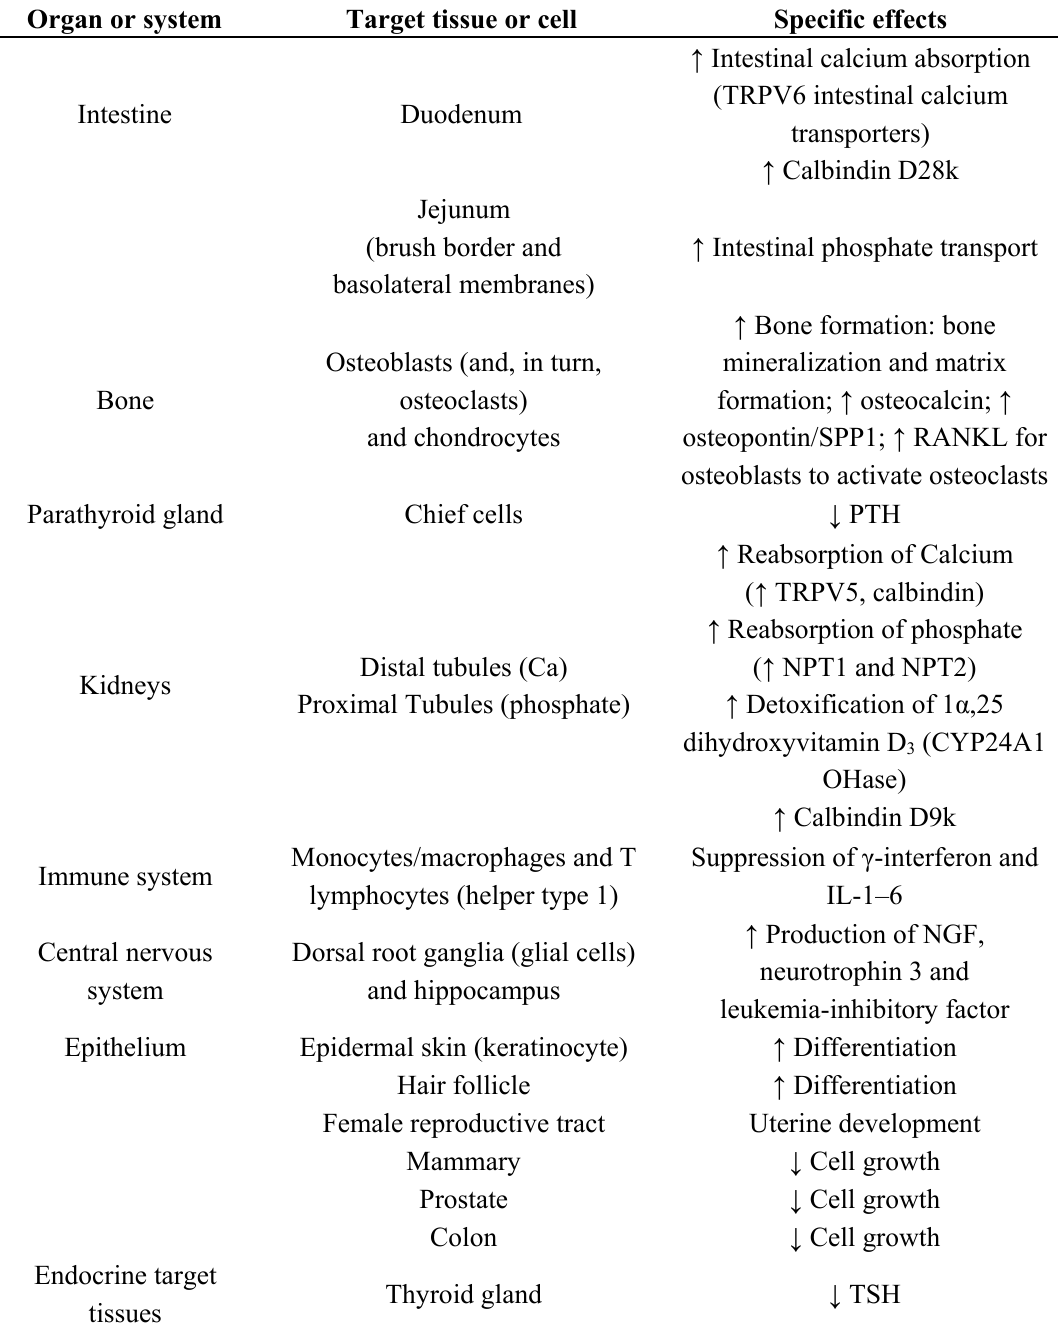
Table 1. Vitamin D can exert its action in several organ systems and tissues of the